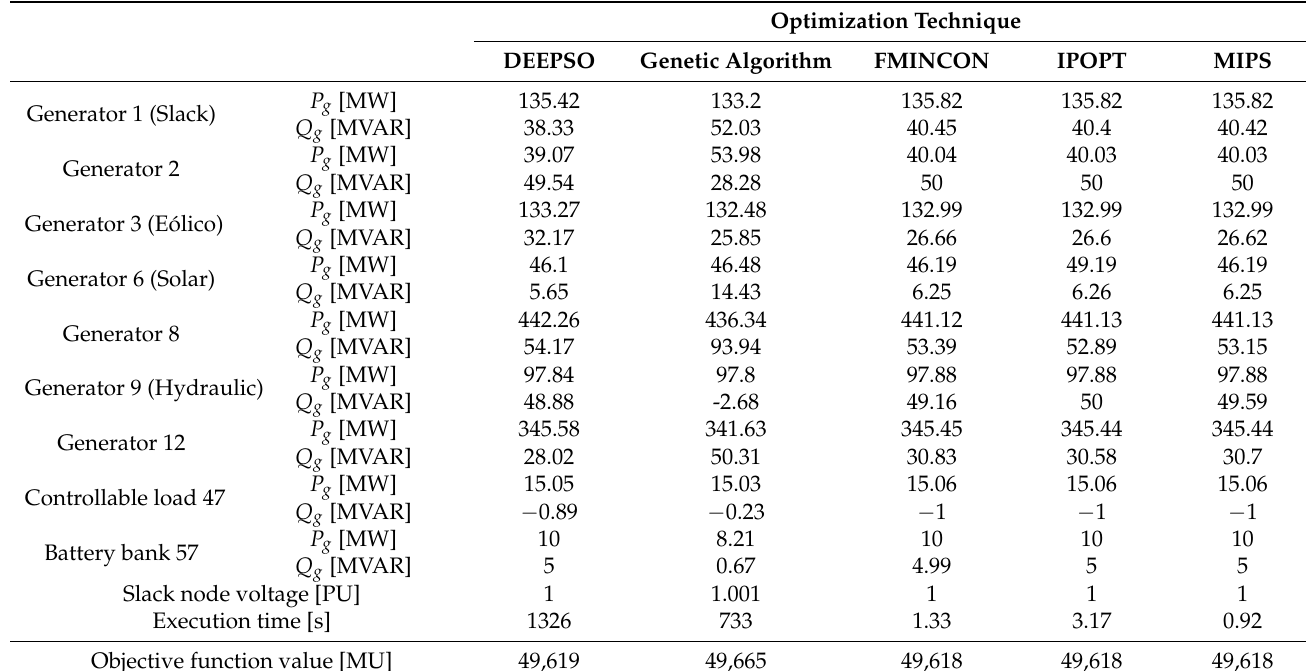
Table 13. Results obtained for the 57 node